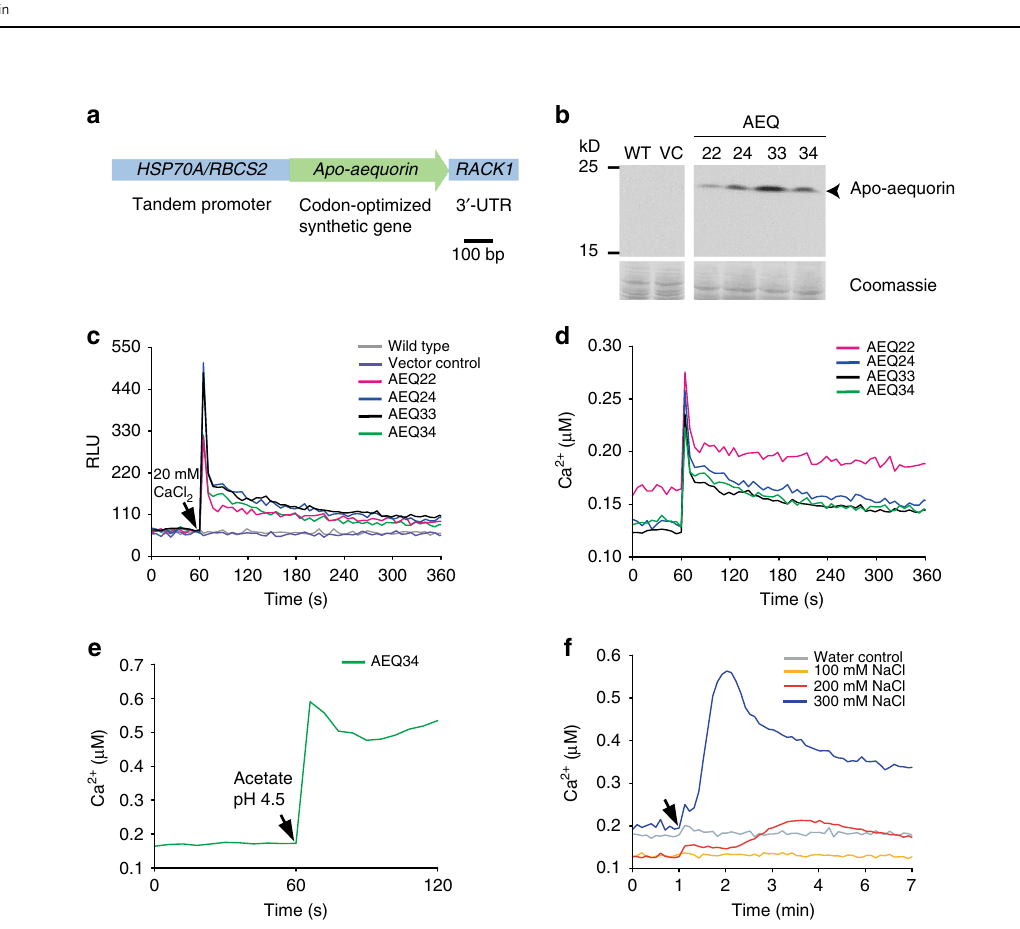
Fig. 3 Establishment of an aequorin-based calcium assay in C . reinhardtii and its applicability for abiotic stresses. a The apo-aequorin expression cassette includes a codon optimized gene and cis -acting elements for ef fi cient expression (Supplementary Fig. 7). b Immunoblot showing the expression of apo- aequorin (22 kD) in transgenic lines AEQ22, AEQ24, AEQ33, and AEQ34 compared to wild type (WT) and a vector control (VC). As a loading control, selected protein bands from the Coomassie-stained PVDF membrane are shown. Another biological replicate showed qualitatively identical results. c , d External calcium triggers luminescence in aequorin-expressing lines. After measuring the resting Ca 2+ concentration in relative light units (RLU), 20 mM of external CaCl 2 were added as indicated by the black arrowhead. Obtained RLU values ( c ) were converted to relative Ca 2+ concentrations ( d ) by triggering maximal luminescence (Supplementary Fig. 8). e Acidi fi cation of the medium causes a prompt increase in cytosolic Ca 2+ ions. After measurement of the resting Ca 2+ concentration, sodium acetate buffer pH 4.5 was added to a fi nal concentration of 20 mM (black arrowhead) to AEQ34 cells in HEPES buffer pH 7.4. f Salt stress results in an increase in Ca 2+ ions. Coelenterazine loaded cells of transgenic aequorin reporter line AEQ34 were treated with increasing concentrations of NaCl (black arrowhead) as indicated. As a control, an equivalent volume of deionized water was used. c – f Each line in the graphs represents the mean of three biological replicates and each biological replicate includes three technical replicates. All experiments were replicated twice except for e , which was done